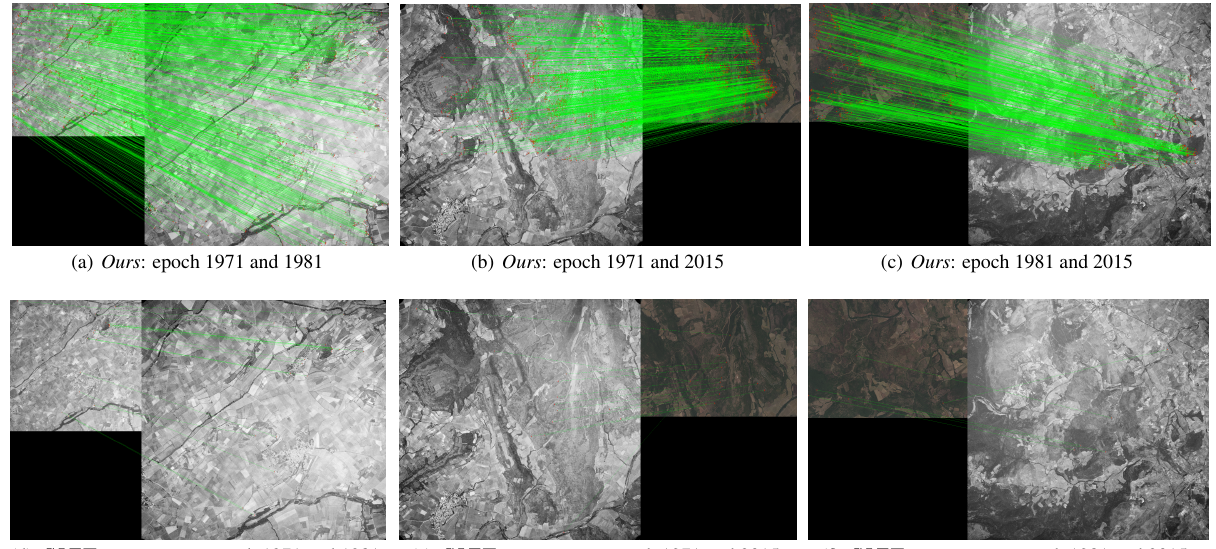
Figure 4. Inter-epoch